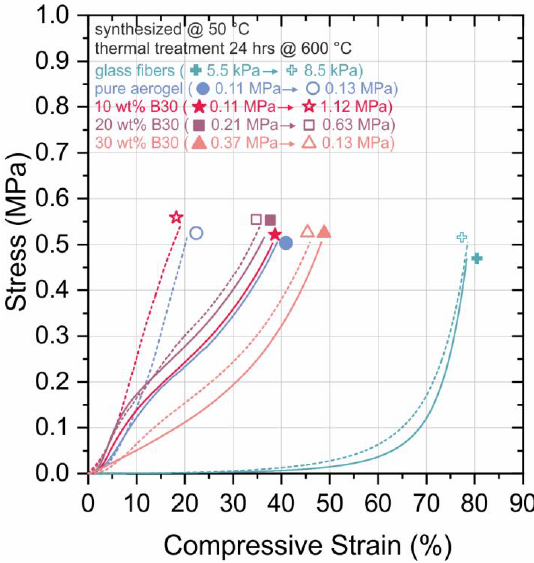
Figure 4. Compression curves of the pure mat of glass fiber (cross, green full lines) and SAs combined with B30 and glass fiber mat (other full symbols, full lines) and after heat treatment for 24 h at 600 °C (other empty symbols, dashed lines).